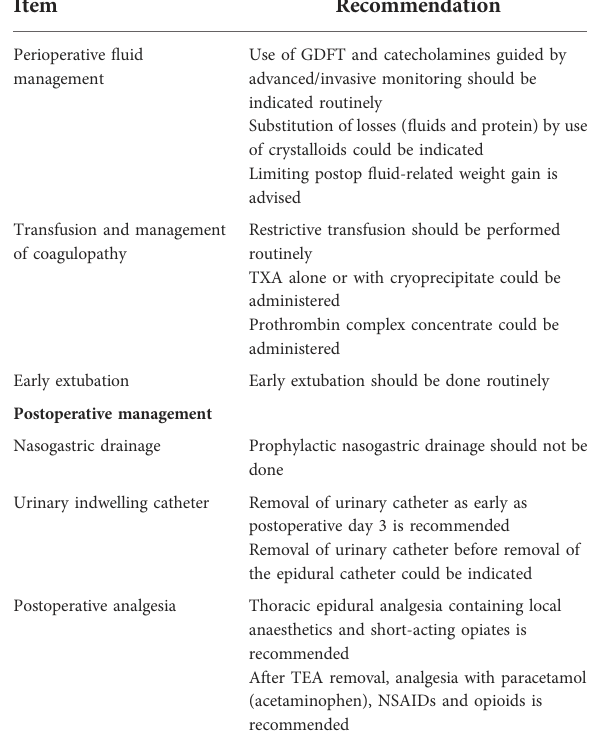
TABLE 2 Preoperative, intraoperative, and postoperative managements for the combined CRS-HIPEC